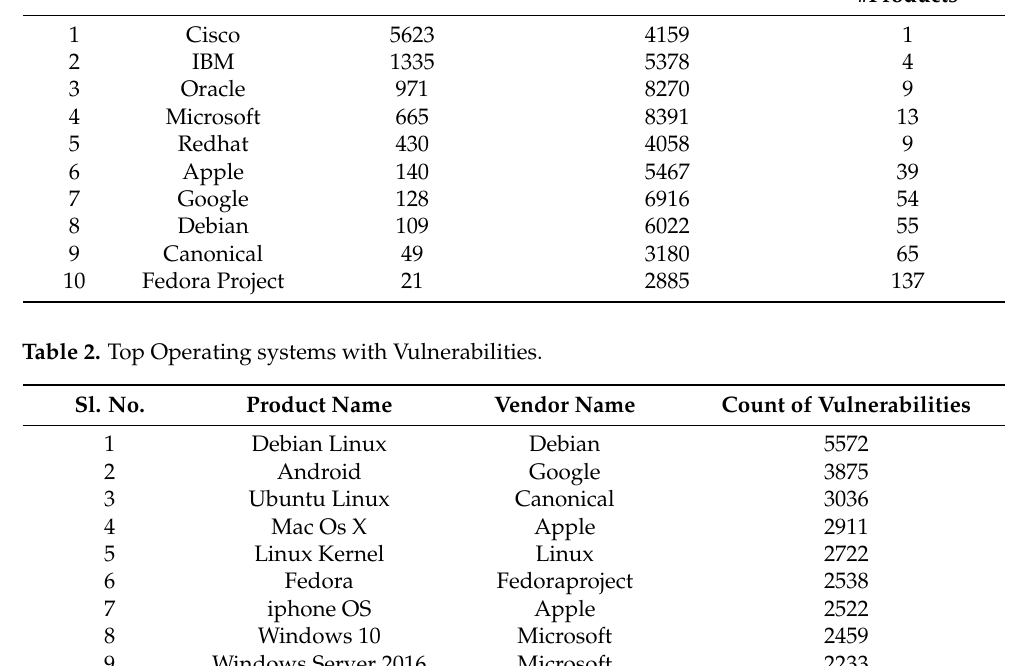
Table 1. Top ten software producers with vulnerabilities. Sl. No.